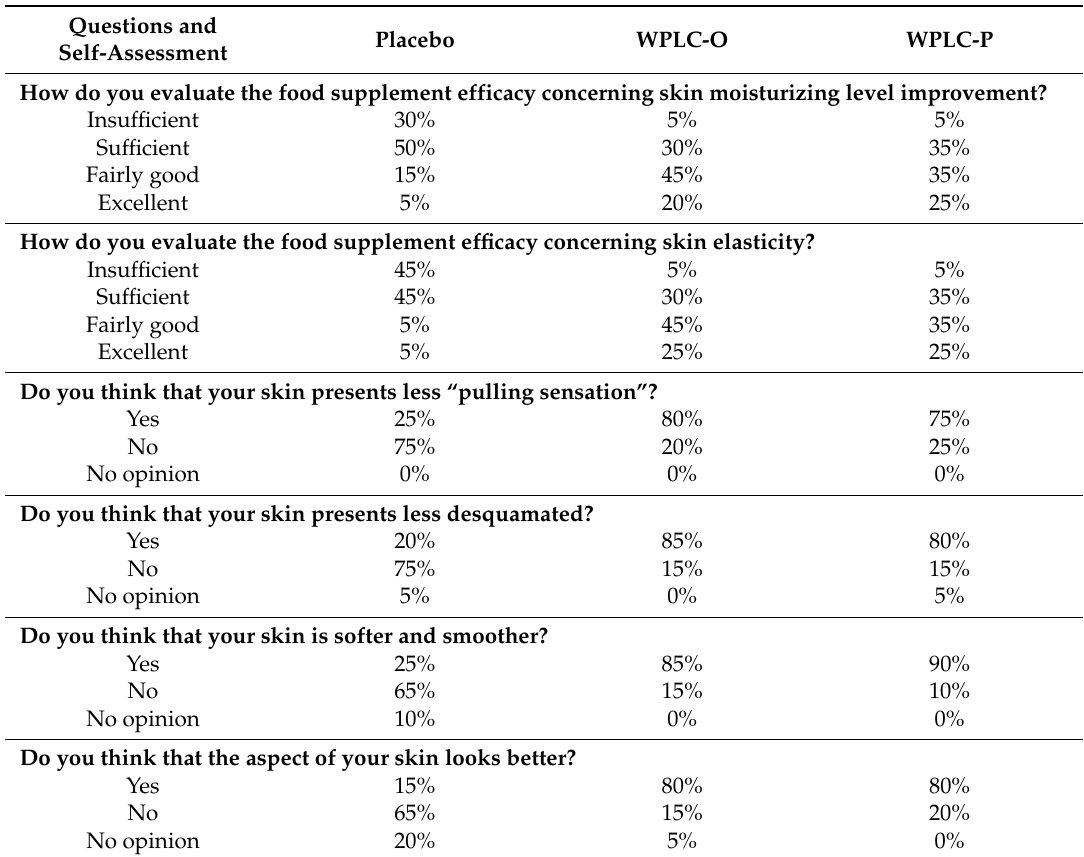
Table 10. Results of the self-assessment questionnaire after 60 days of supplementation with WPLC-O and